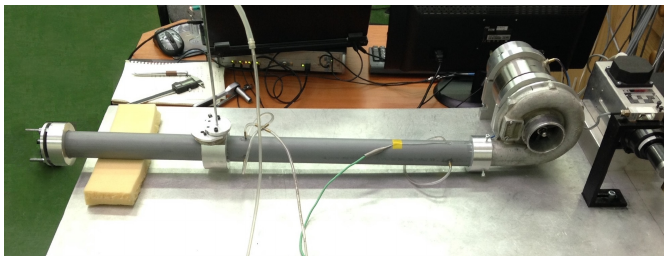
Figure 5: Test rig-blower mounted with a measurement